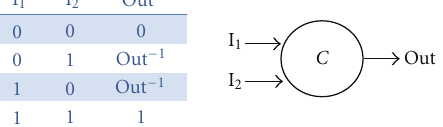
Figure 3: PLB architecture.